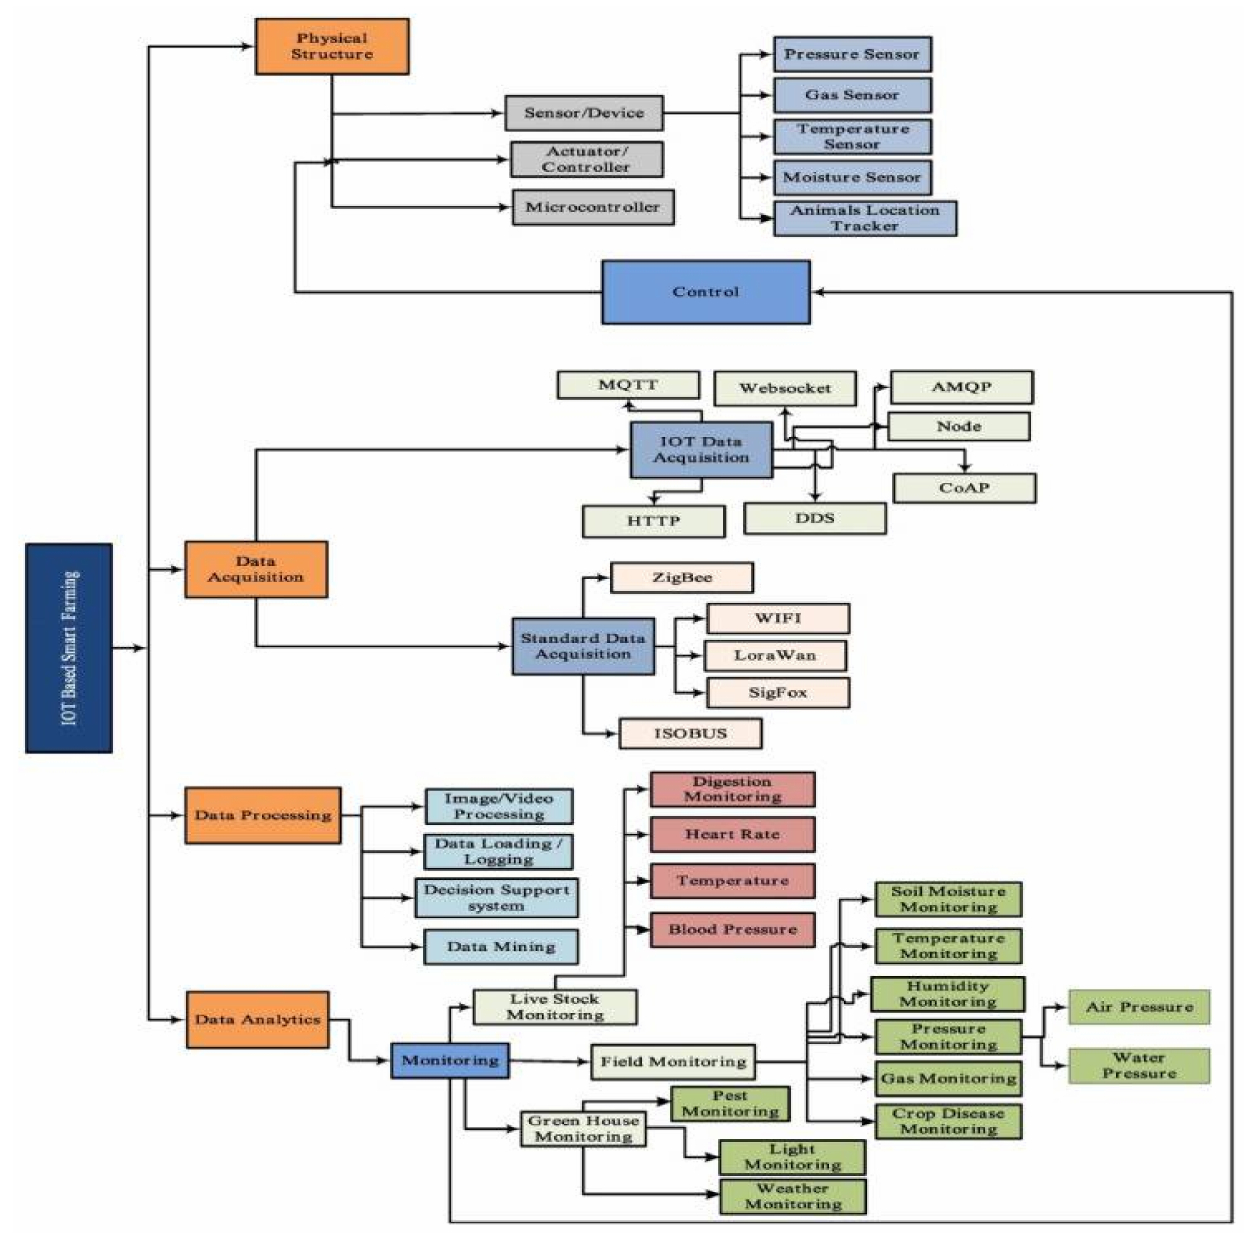
Figure 1. IoT smart farming framework Farooq et al.